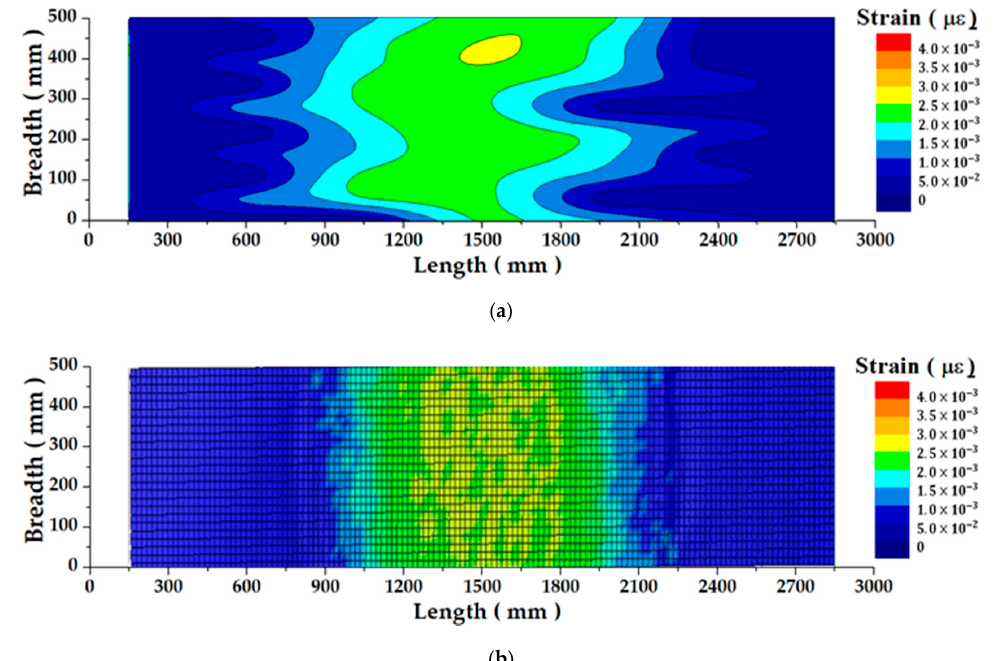
Figure 10. Comparison of CFRP strain distributions using BOTDR sensor and analysis (M-50). ( a ) BOTDR, ( b ) FEM.